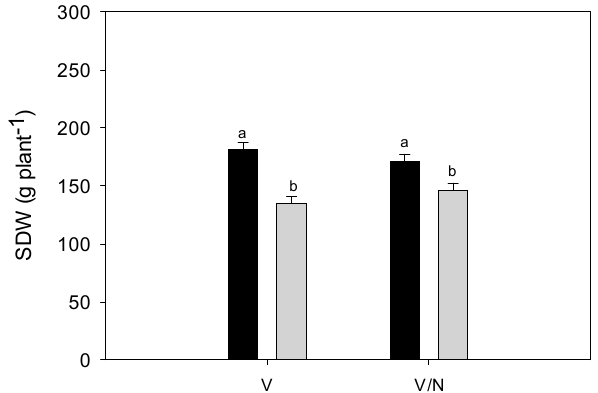
Figure 5. Shoot dry weight (SDW, g plant − 1 ) for the deficit irrigation plants (gray bars) and the control plants (black bars) in the ungrafted pepper plants (V) and the cultivar grafted onto NIBER ® (V / N). Data are the mean values for n = 6. In each plant combination, di ff erent letters indicate significant di ff erences at p ≤ 0.05. Error bars represent the LSD value of the interaction.